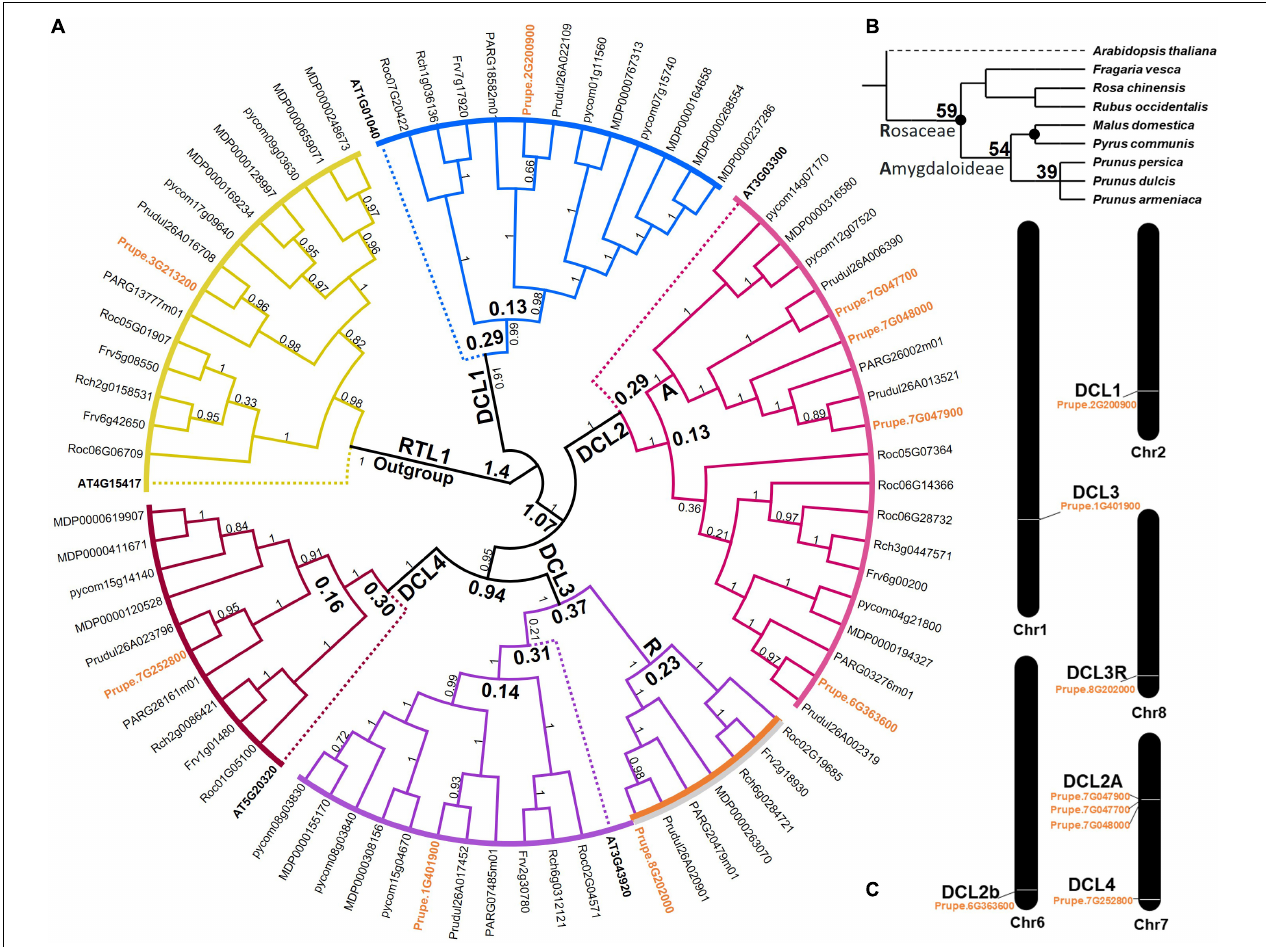
FIGURE 2 | The time-calibrated maximum liklihood phylogenetic tree of DCLs genes of eight Rosacea species. (A) The circular dendogram with colored clusters, each represent one DCL and the RTL1 outgroup. The Prunus persica DCL genes are colored with orange while Arabidopsis DCL genes are marked by dot-lines. The Rosaceae specific DCL3 copy cluster was outlined by orange-gray bolded line and named by letter (R). The Amygdaloideae specific DCL2 copy cluster is named by letter (A). (B) Taxonomy-based relationship of the eight Rosaceae species timely calibrated using data obtained from www.timetree.org/. Black ovals suggest whole-genome duplication (WGD) occurrences. (C) Distributions of DCLs genes on Prunus persica chromosomes. Eight DCLs genes are mapped on five out eight chromosomes. The Amygdaloideae specific DCL2 triple copies are adjacent on chromosome